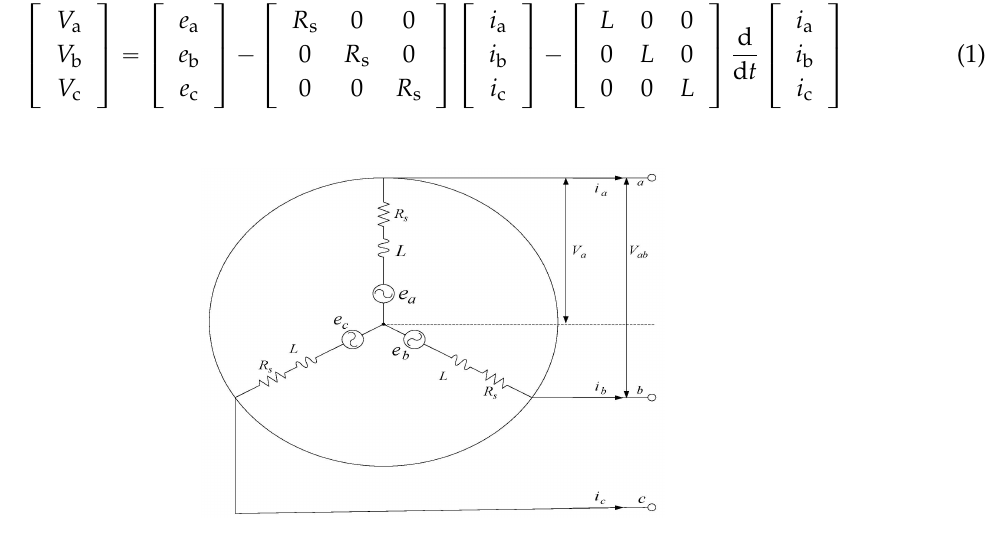
Figure 1. Generator equivalent